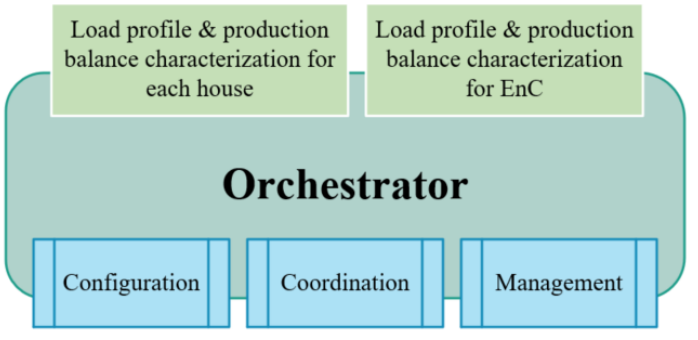
Figure 8. EnC decision support entity.